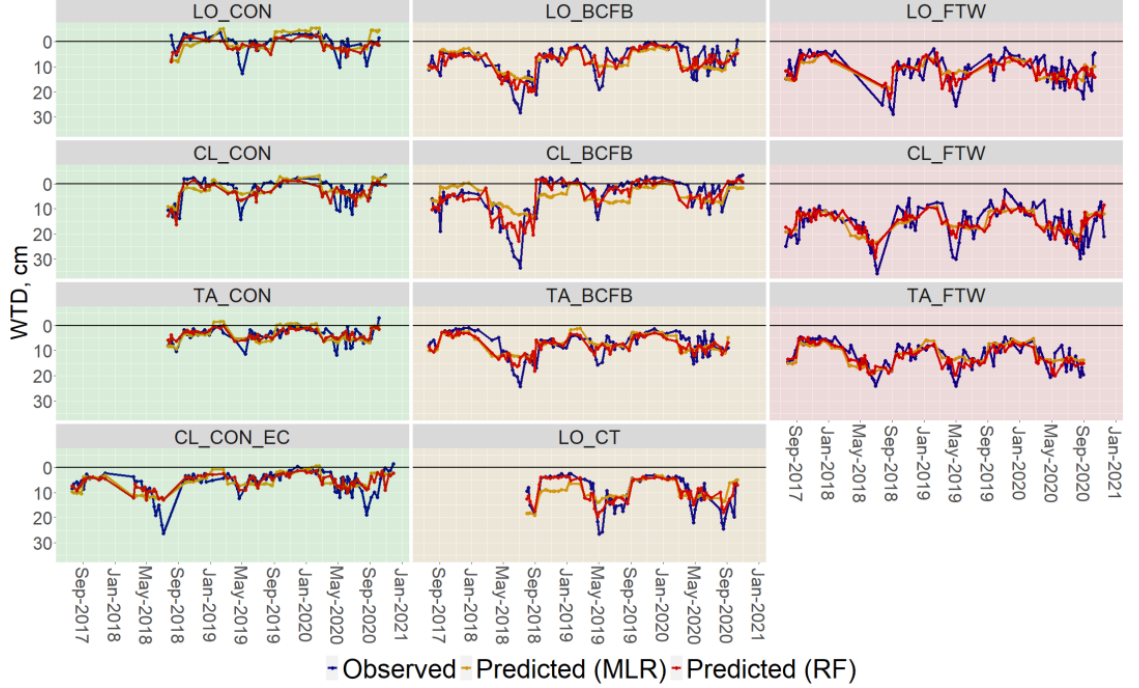
Figure 11. Modelled and observed water table depth series based on the MLR and RF models. The black horizontal line indicates the ground surface. Panels with a green background indicate the control sites, orange — Restoration+ sites, and red — Restoration (FTW) sites.